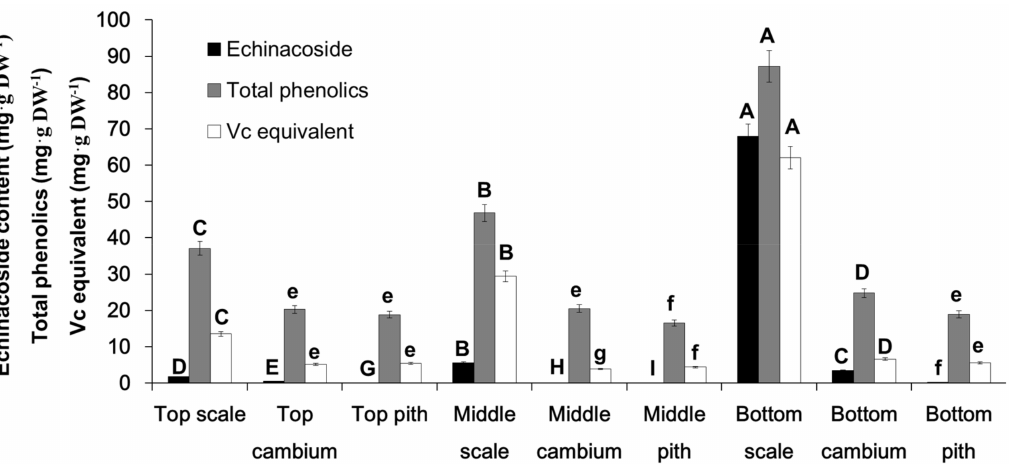
Figure 2. Content determination of echinacoside, total phenolics, and Vc equivalent in different tissues and parts of C. deserticola . Letters above the columns represent significance (A–I: p < 0.01; a–h: p <